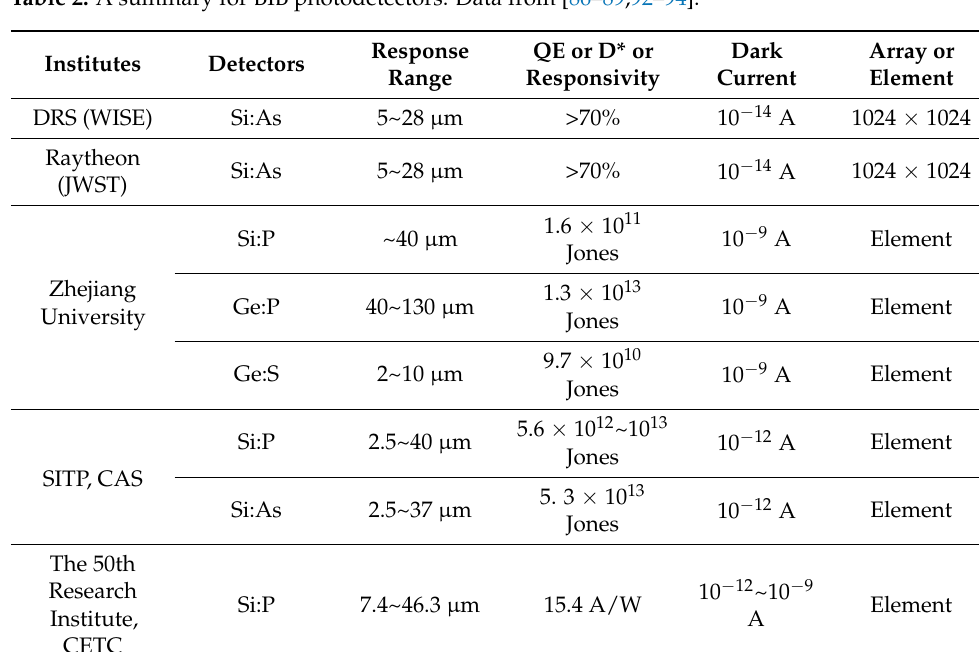
Figure 5. BIB PDs. ( a ) Photocarrier transport model of the BIB detector. ( b ) The detective range of various BIB detectors. Table 2. A summary for BIB photodetectors. Data from